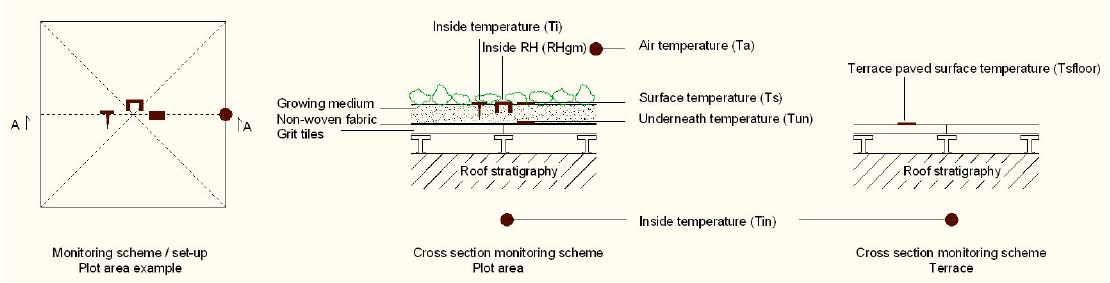
Figure 3. Plots monitoring scheme. Left side: plot area example; center: cross-section of the monitoring scheme—plot area; right side: cross-section of the monitoring scheme—terrace.